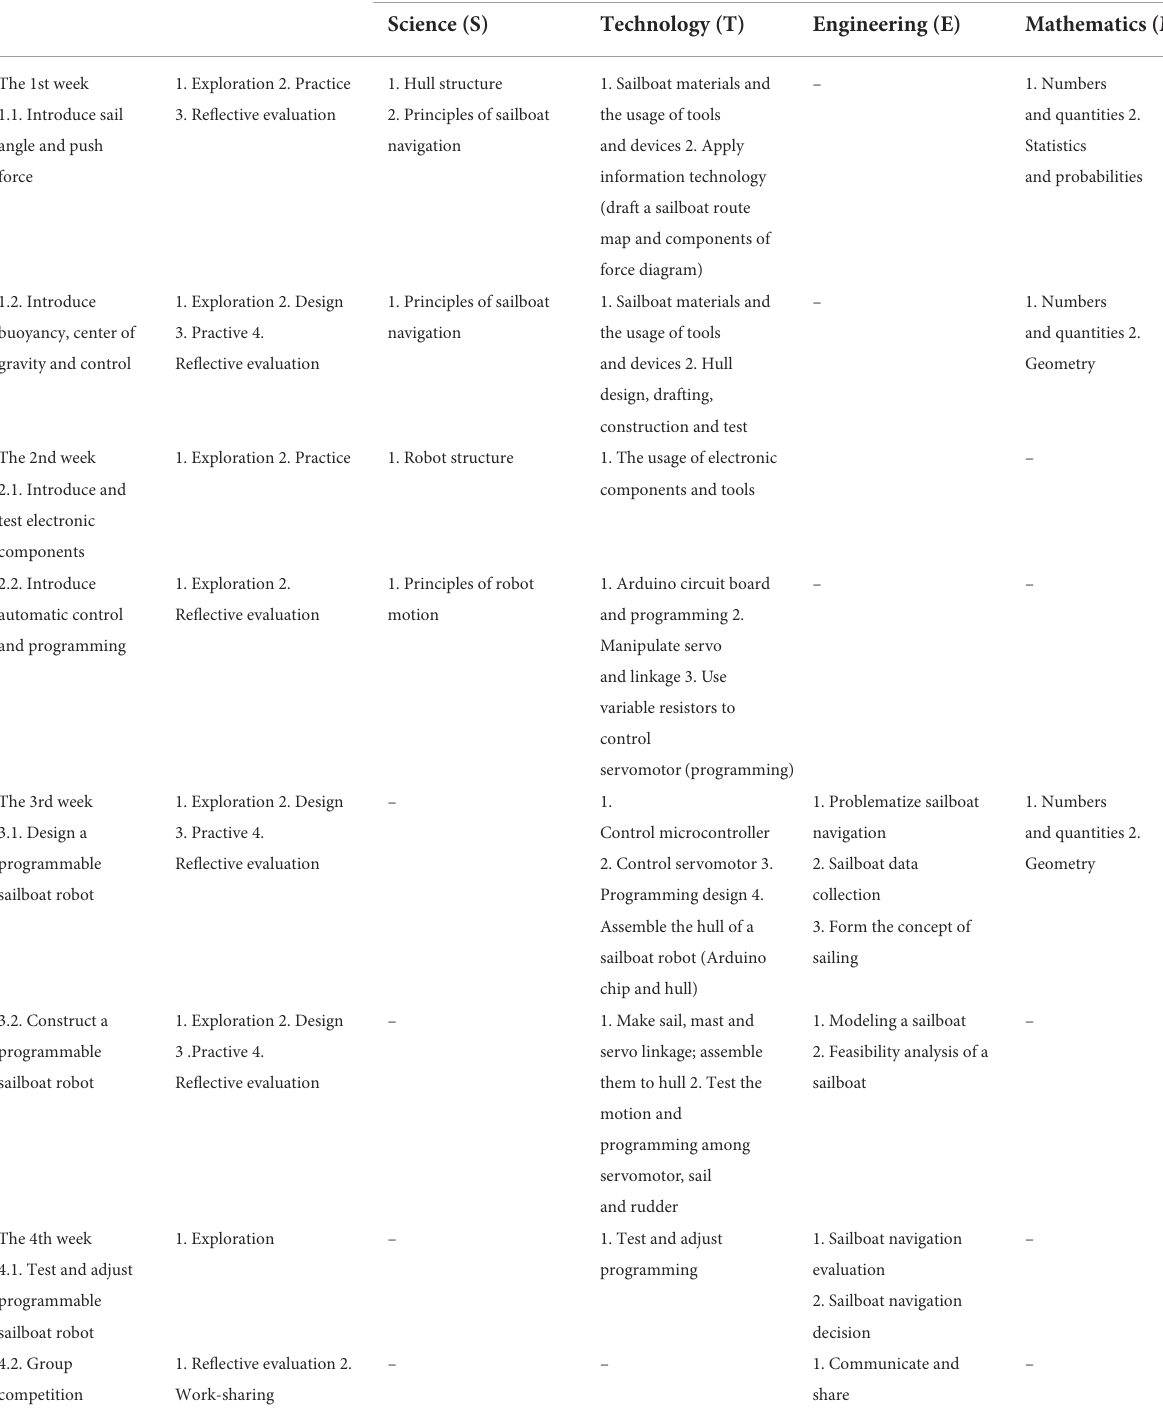
TABLE 1 STEM knowledge framework and PjBL activities. Activity